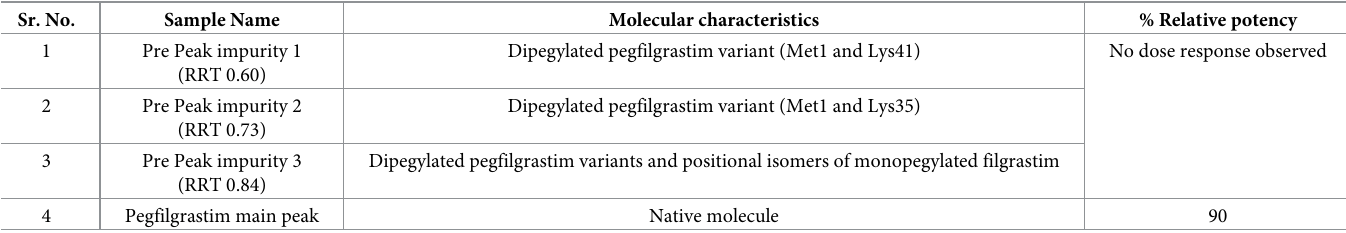
Table 3. Summary of characterization of Pre-peak Impurities 1, 2, 3 and pegfilgrastim main peak from the pegylation reaction output. Sr. No.